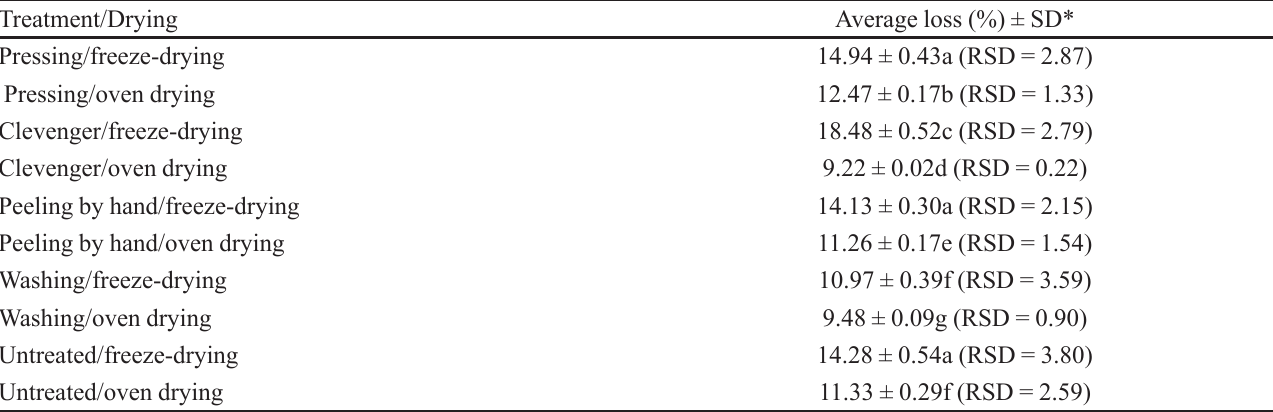
*Different letters indicate statistically significant differences between values (p <